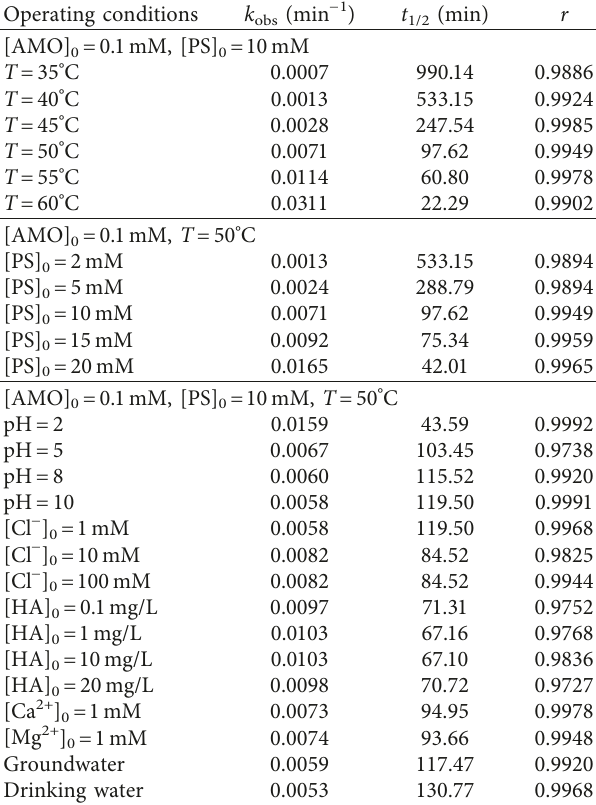
Table 1: Kinetic parameters of AMO degradation by TAP at different